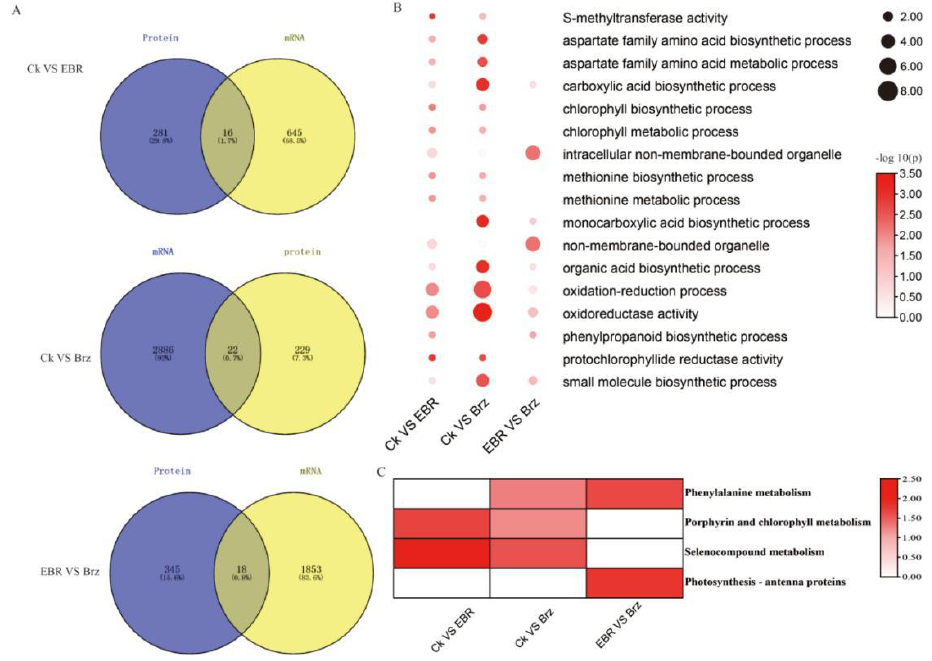
Figure 5. Enrichment analysis of the BR-responsive combined transcriptome and proteome changes in maize leaves. ( A ) The Venn diagrams of differentially expressed proteins were analyzed statistically. ( B ) The GO enrichment analysis of DEGs is shown as a heat map. ( C ) The KEGG enrichment analysis of DEGs is shown as a heat map.